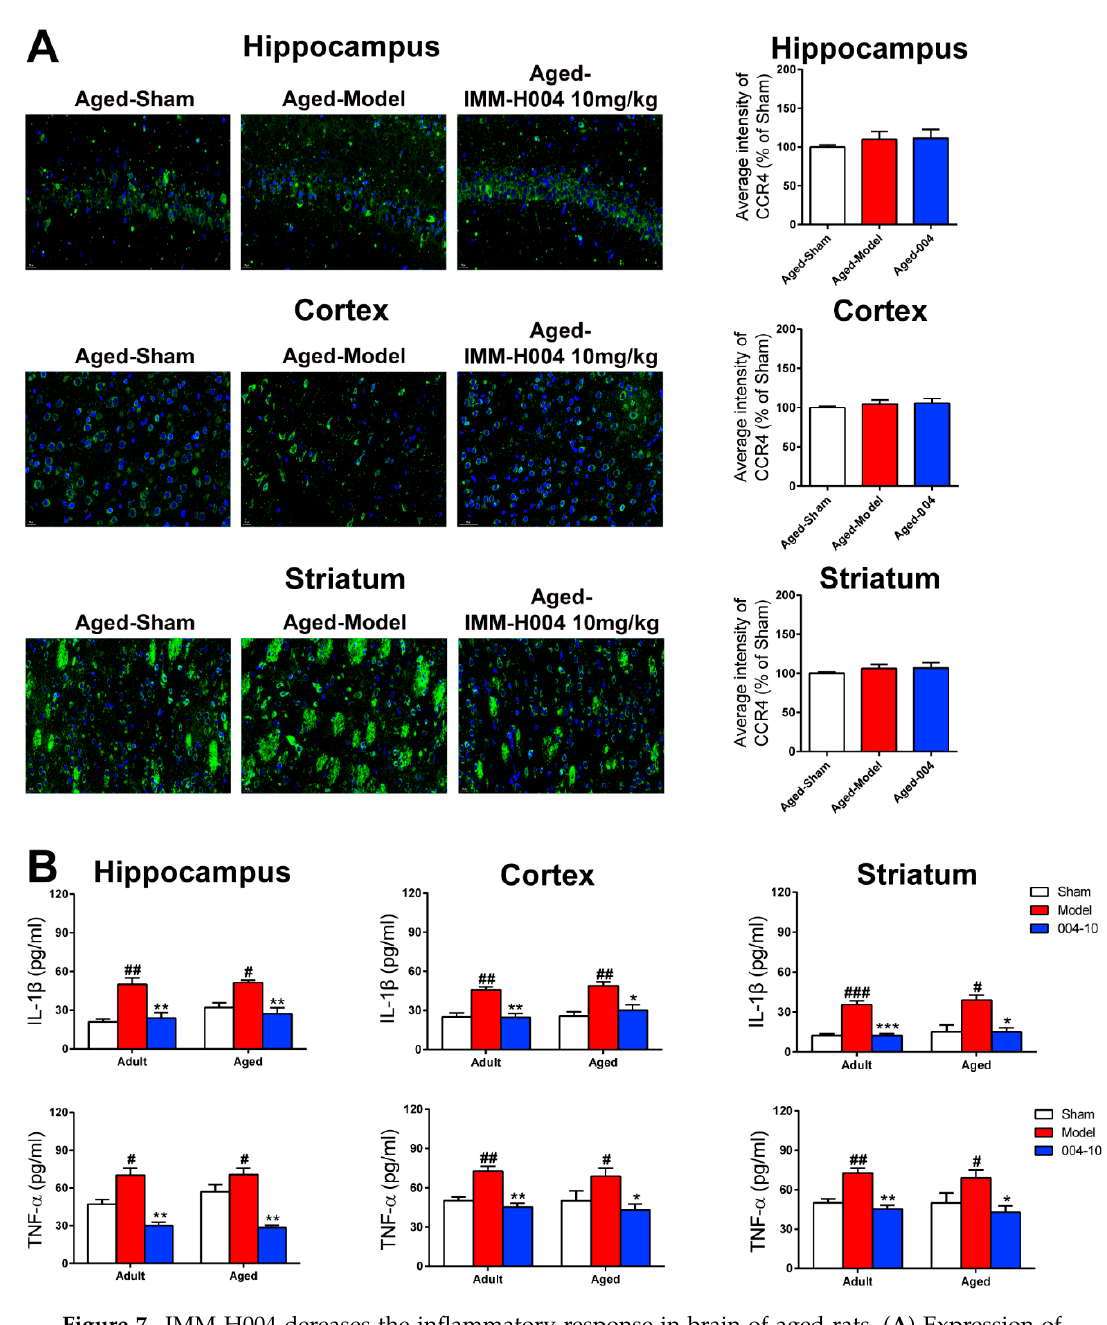
Figure 7. IMM-H004 dereases the inflammatory response in brain of aged rats. ( A ) Expression of CCR4 in hippocampal CA1, cortex, and striatum subfield from aged rats by immunofluorescence staining (400 × magnification, scale bar: 50 µ m). ( B ) Effect of IMM-H004 on IL-1 β and TNF- α levels in hippocampus, cortex, and striatum of aged rats. All the data are shown as the mean ± SD; part of data are shown as the mean ± SD after normalization to the sham ( n = 6/group). # p < 0.05 vs. sham; ## p < 0.01 vs. sham; ### p < 0.001 vs. sham; * p < 0.05 vs. model; ** p < 0.01 vs. model; *** p < 0.001 vs.